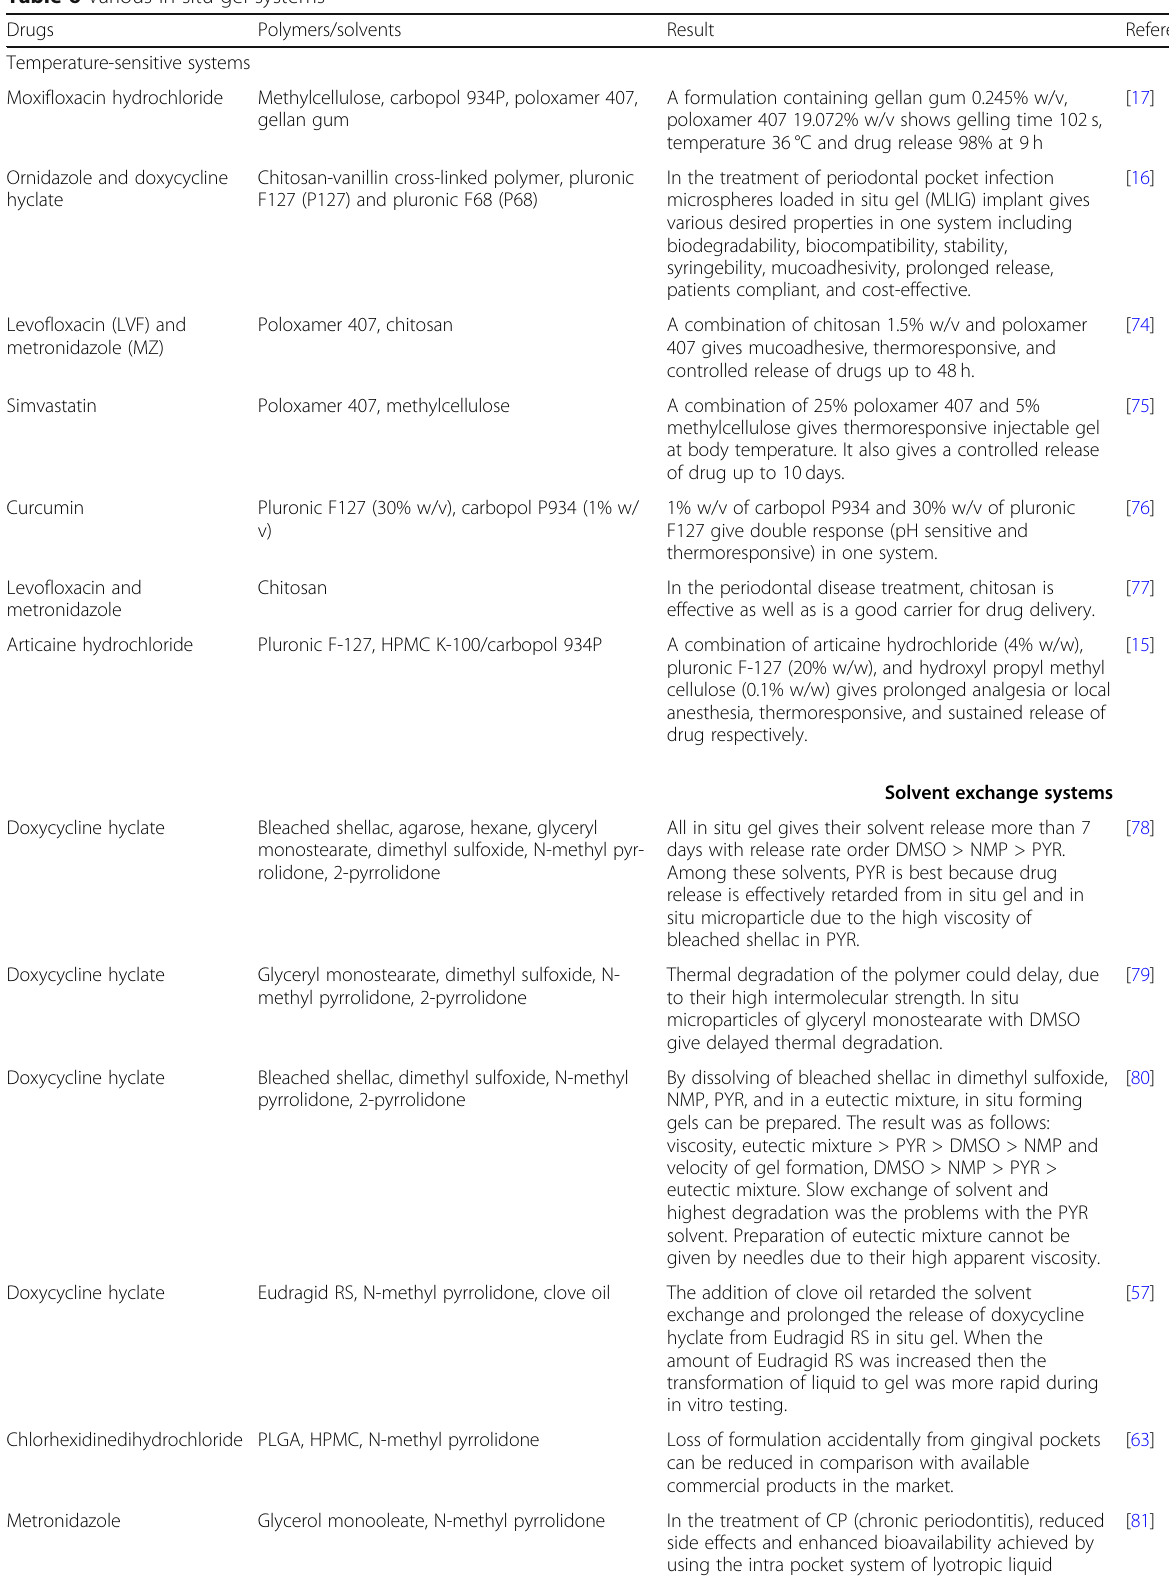
Table 6 Various in situ gel